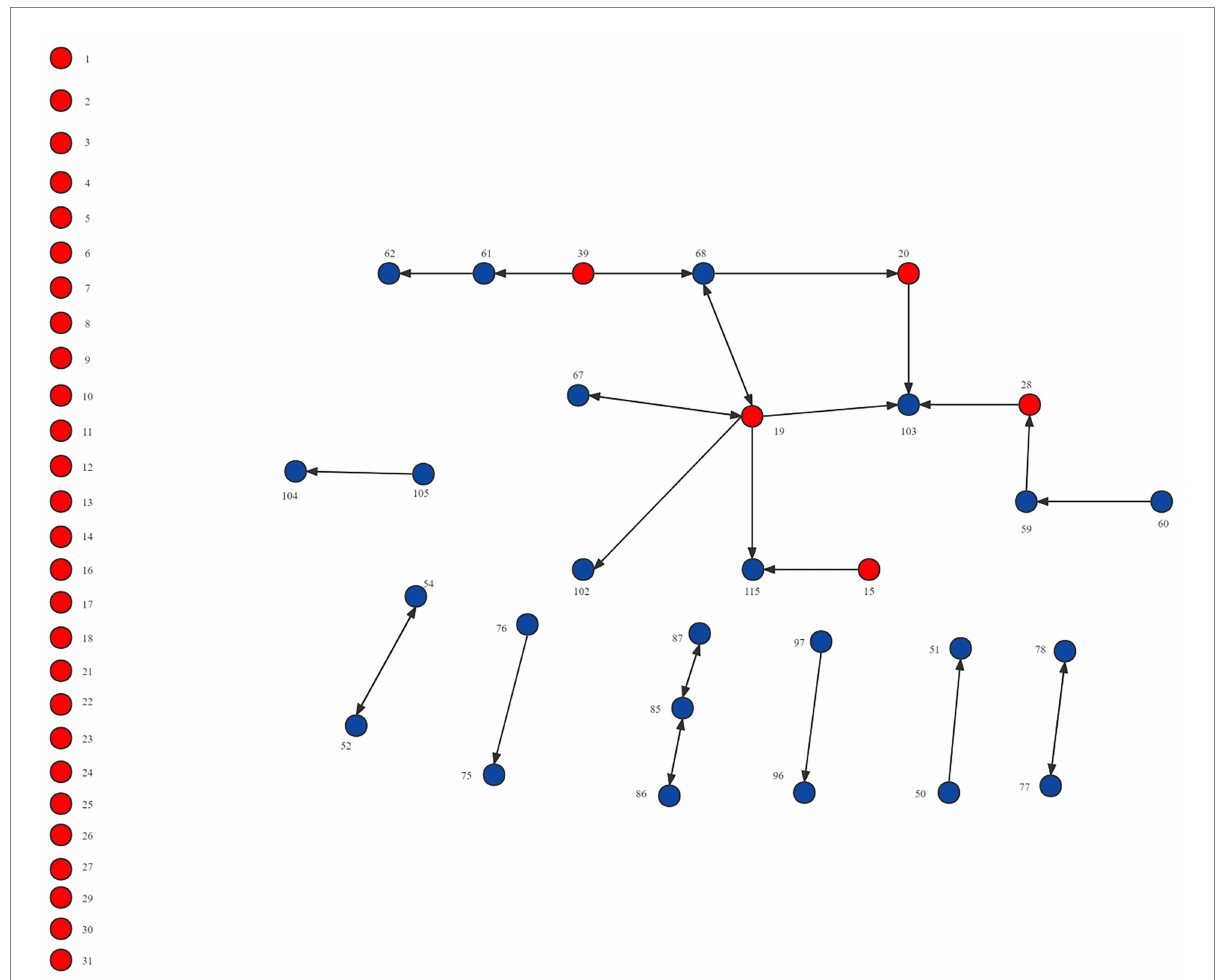
FIGURE 4 Network visualization of the inter-organizational knowledge sharing network for health technology in the Fujian liver disease specialist medical